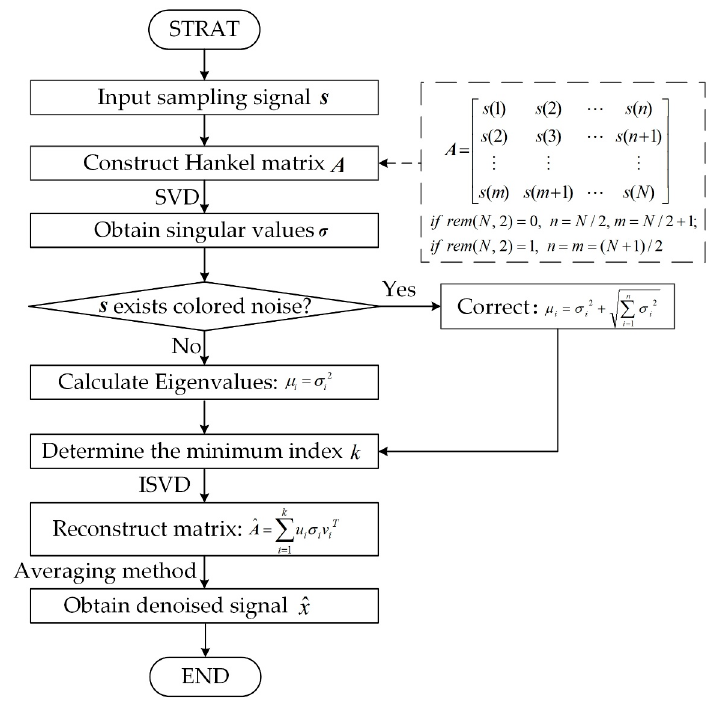
Figure 2. Flow chart of the signal denoising method using AIC–SVD. SVD: singular value.decomposition.